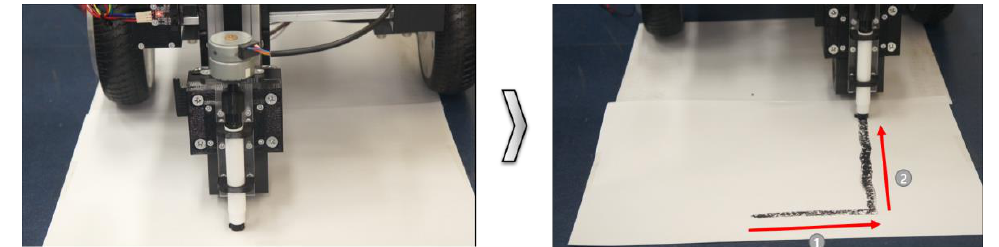
Figure 11. Before and after the y-axis movement marking functionality test.